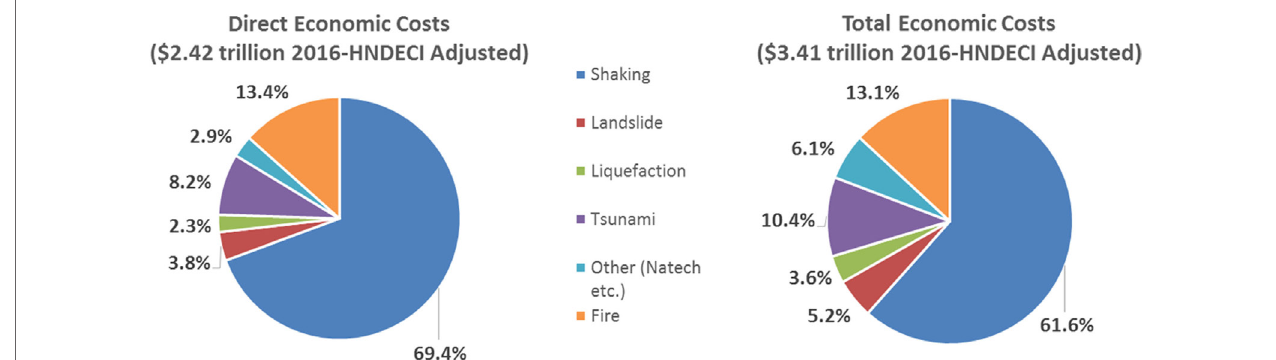
FigUre 7 | Disaggregation of shaking and secondary effects economic costs from 9,920 earthquakes from 1900 to 2016—left: direct economic costs; right: total economic costs .